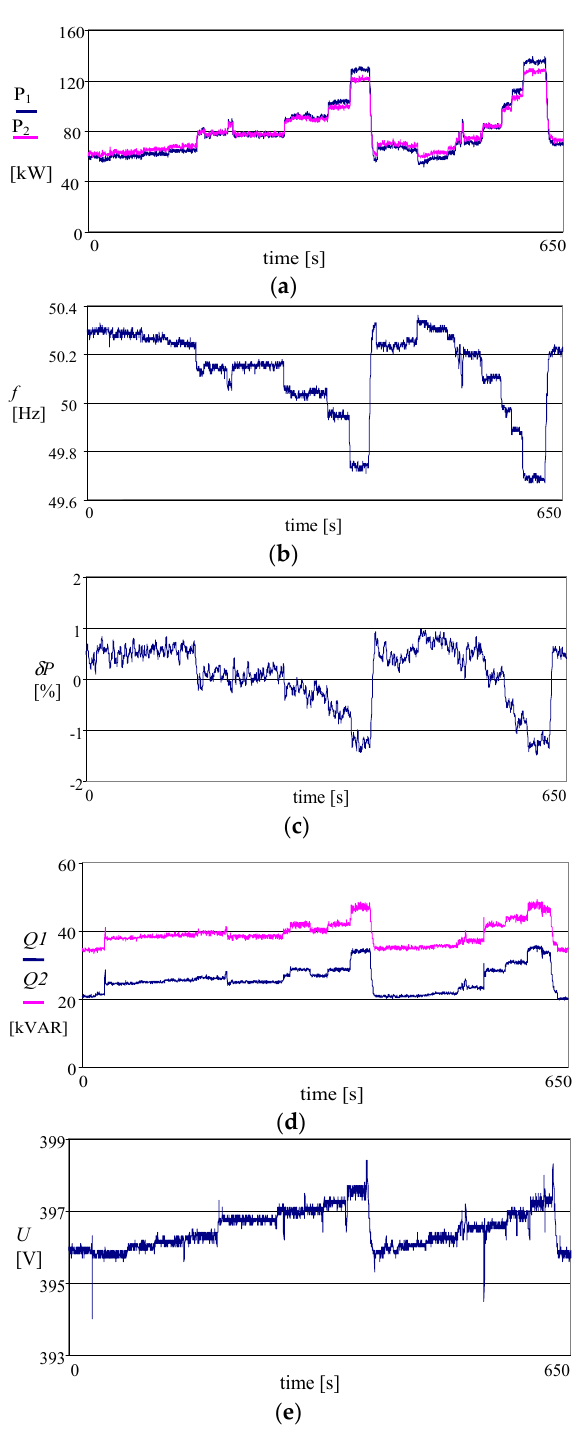
Figure 7. Variations of the basic parameters when two generators are running in parallel: ( a ) active power; ( b ) frequency; ( c ) proportionality of active power sharing; ( d ) reactive power; ( e ) voltage on main bus